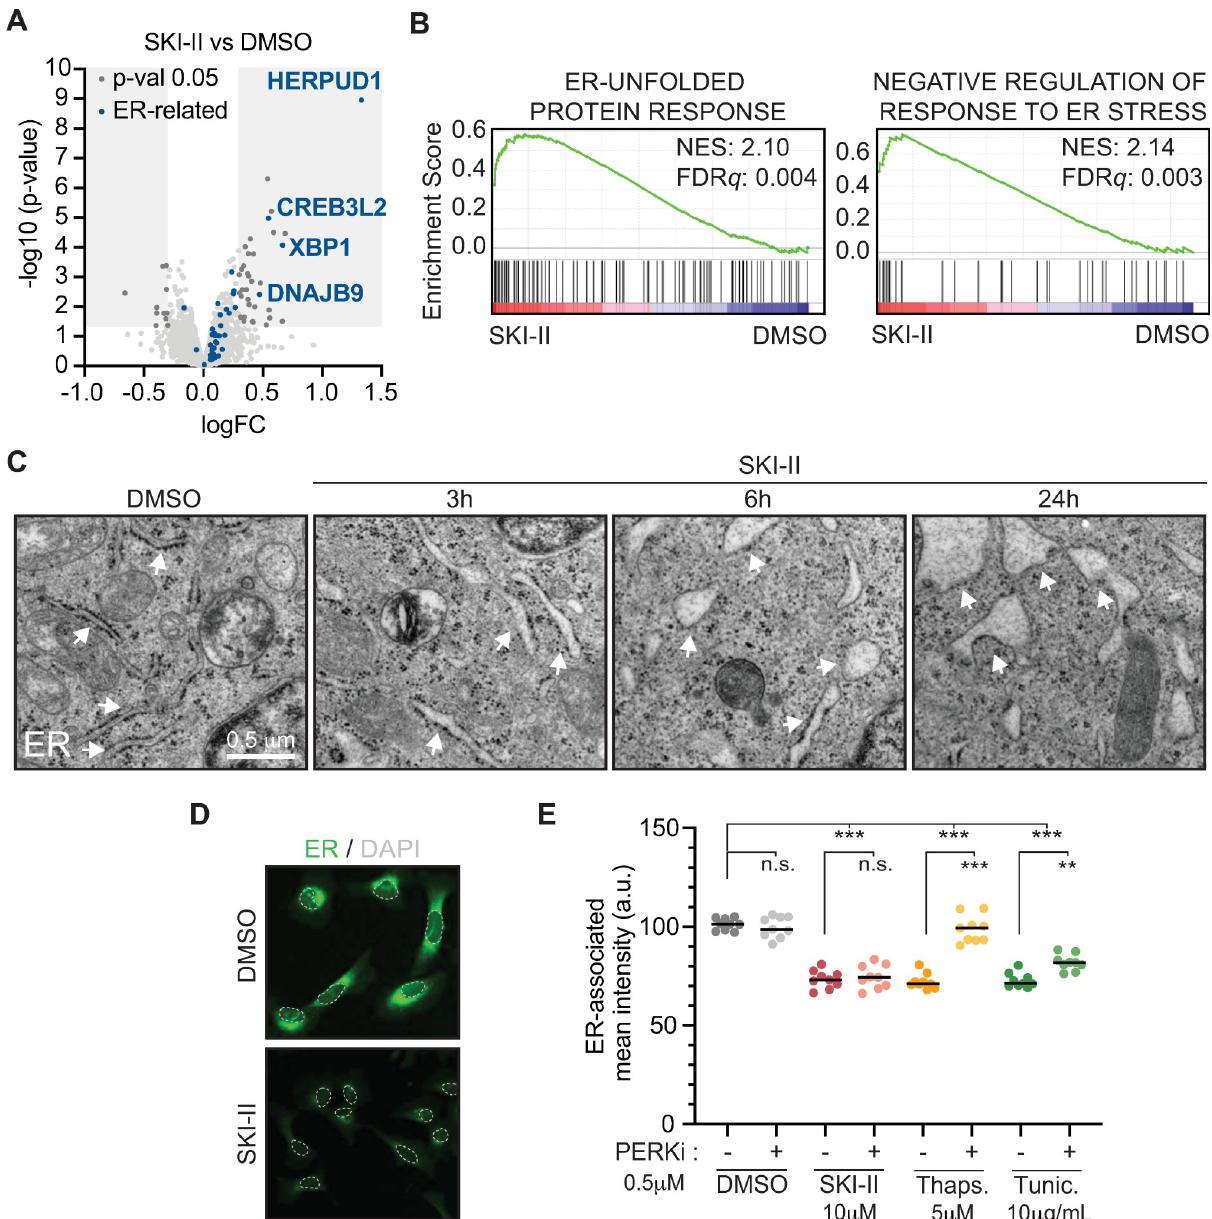
Fig 3. SKI-II specifically affects ER membranes. (A) Volcano plot representing the data from a proteomic experiment in U2OS cells treated with SKI-II (10 μ M, 6 h) compared to a DMSO-treated control. Proteins within the GRAY boxes are differentially regulated ( p < 0.05). Factors in BLUE are related to the ER stress response. Data A in S3 Data. (B) GSEA from the experiment defined in (A) showing a significant enrichment in GO terms “ER- unfolded protein response” (NES: 2.10, FDRq: 0.004) and “negative regulation of response to ER stress” (NES: 2.14, FDRq: 0.003) for cells exposed to SKI-II. Data B in S3 Data. (C) TEM images of U2OS cells treated with SKI-II (10 μ M) for 3, 6, and 24 h. Cells were exposed to DMSO as a control. White arrows point at the ER. Ribosomes are black electrodense particles situated around the cisterns of the ER. Scale bars, 0.5 μ m. (D) Representative image illustrating the reduction in ER-associated signal (GREEN) in U2OS cells exposed to SKI-II (10 μ M) for 3 h compared to the DMSO control. Nuclei were stained with Hoechst (dashed GRAY line). (E) HTM-dependent quantification of ER-associated mean intensity in U2OS cells exposed to PERKi (0.5 μ M) for 1 h and then to SKI-II (10 μ M), Thaps. (5 μ M), or Tunic. (10 μ g/mL) for additional 3 h. In HTM quantifications, every dot represents the mean value of the measurements taken by well from 3 independent experiments. Data E in S3 Data. Statistical analyses were done using one-way ANOVA tests. ��� p < 0.001. DMSO, dimethyl sulfoxide; ER, endoplasmic reticulum; GO, Gene Ontology; GSEA, Gene Set Enrichment Analysis; HTM, high-throughput microscopy; n.s., not significant; PERKi, PERK inhibitor; TEM, transmission electron microscopy; Thaps., Thapsigargin; Tunic., Tunicamycin.